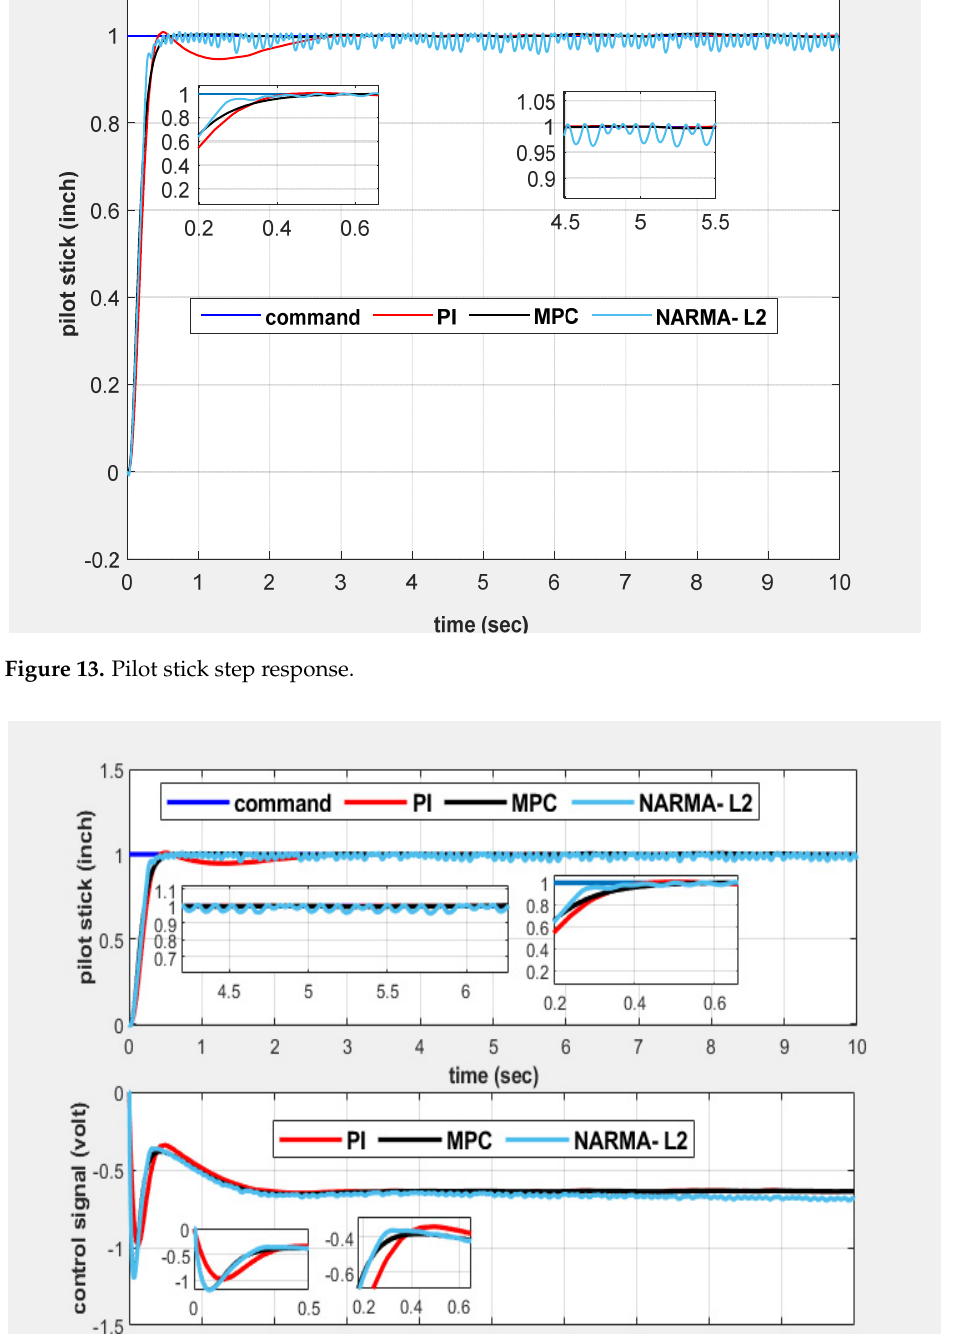
Figure 14. Pilot stick step response with corresponding error.